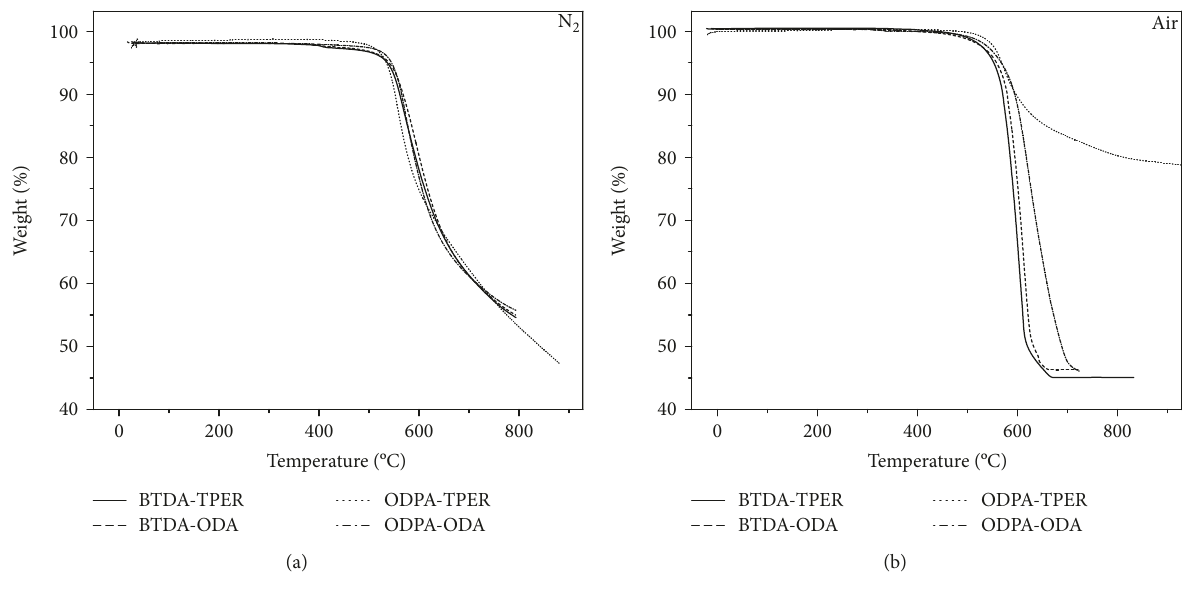
Figure 6: TGA curves of Table 3: Weight loss temperatures of polyimides.